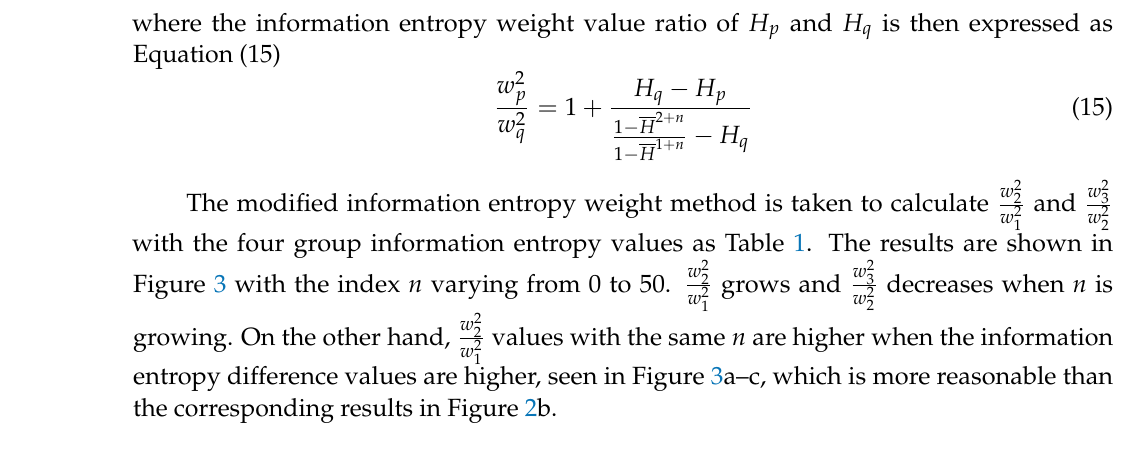
2 2 and w varying by different n values in group 2. 3 2 w 2 1 w 2 2 2 2 and w varying by different n values in group 4. 3 2 w 2 1 w 2 2